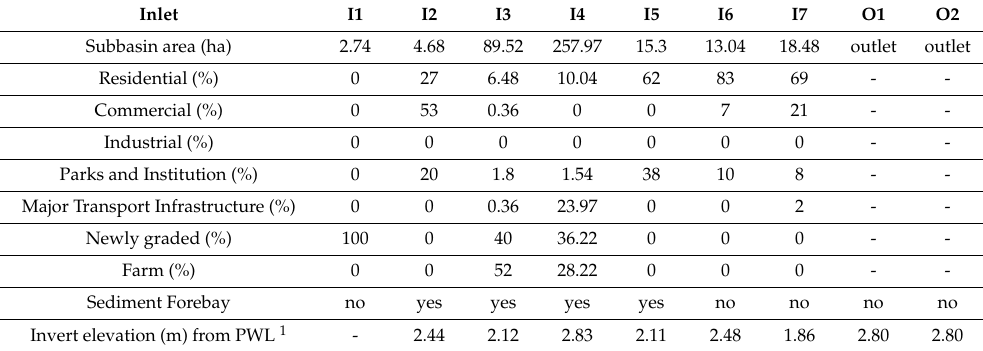
Table 1. Inlet and outlet parameters of the Inverness stormwater